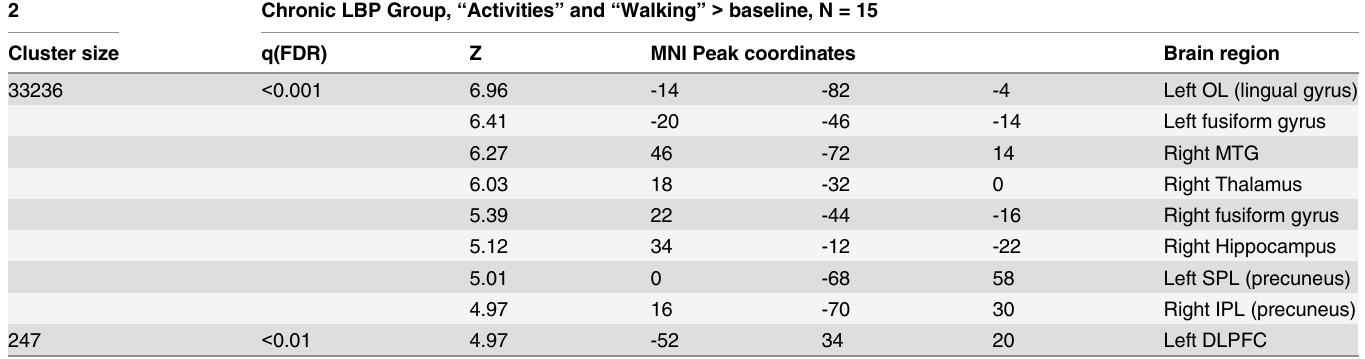
Table 2. Brain activity of the chronic Low Back Pain (LBP) group, peak activations. Cluster maxima of brain activity of the video clips of activities of daily living ( “ Activities ” ) and walking activities ( “ Walking ” ) together. All results are false discovery rate corrected (FDR, q < 0.05). MNI = Montreal